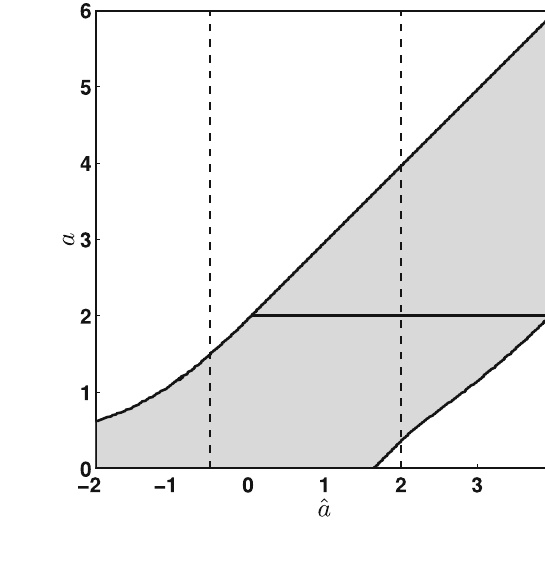
and that the unknown parameter a represents the amplitude of a signal, so that a >